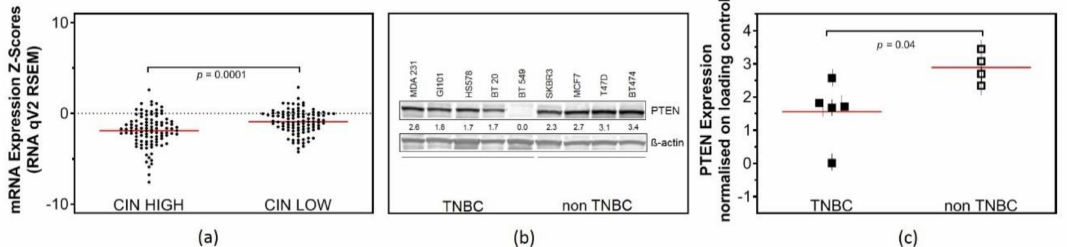
Figure 1. High chromosomal instability (CIN) scores and low phosphatase and tensin homolog (PTEN) expression in triple-negative breast cancer (TNBC). ( a ) In silico analysis of PTEN mRNA expression data, comparing 100 TNBC patients with a high CIN70 score to 100 TNBC patients with a low CIN70 score. (Student’s t -test p = 0.0001) ( b ) Western Blot analysis of PTEN expression in TNBC (MDA231, BT549, BT20, GI101 and HS578T) and non-TNBC breast cancer cell lines (MCF7, T47D, SKBR3, BT474) in relation to ß-actin as loading control. ( c ) Grouped analysis of quantitative PTEN expression normalized on ß-actin, comparing TNBC and non-TNBC breast cancer cell lines. (Student’s t-test p = 0. 0416).